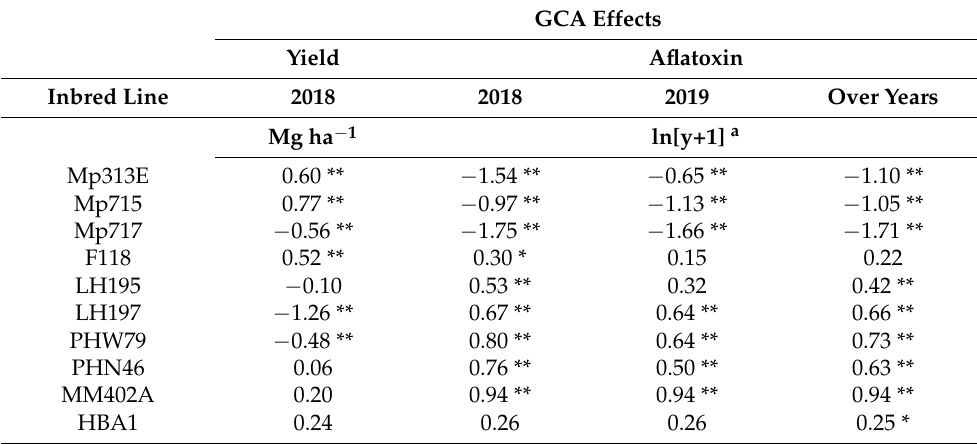
Table 4. Estimates of general combining ability (GCA) effects of 10 inbred maize lines evaluated for yield and aflatoxin accumulation in a diallel cross.